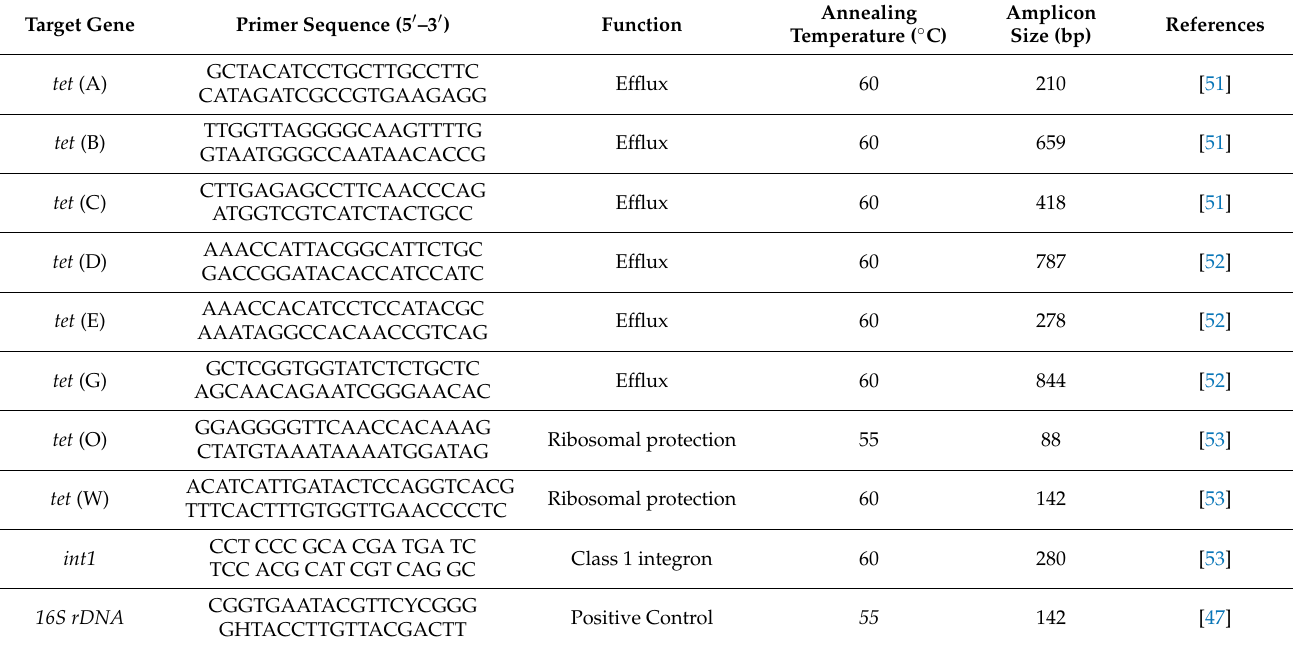
Table 4. Primers and the annealing temperatures used in this